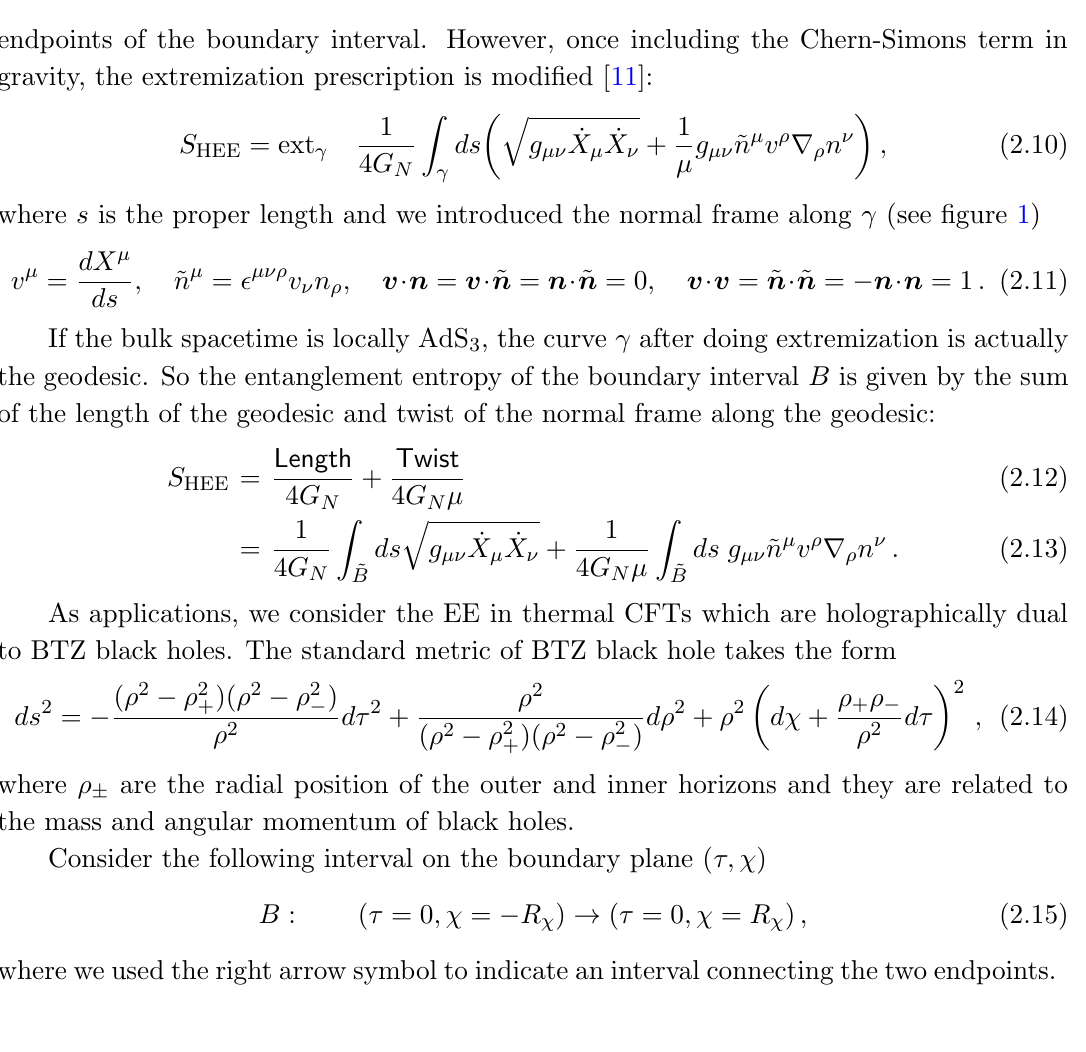
Figure 1 . The geometric picture of HEE in TMG. B : the boundary interval, ~ B : the geodesic homologous to B , C : the surface enclosed by B and ~ B , ( v ; n ; ~ n ): the normal frame along the geodesic. The plane is the boundary of AdS and CFT lives